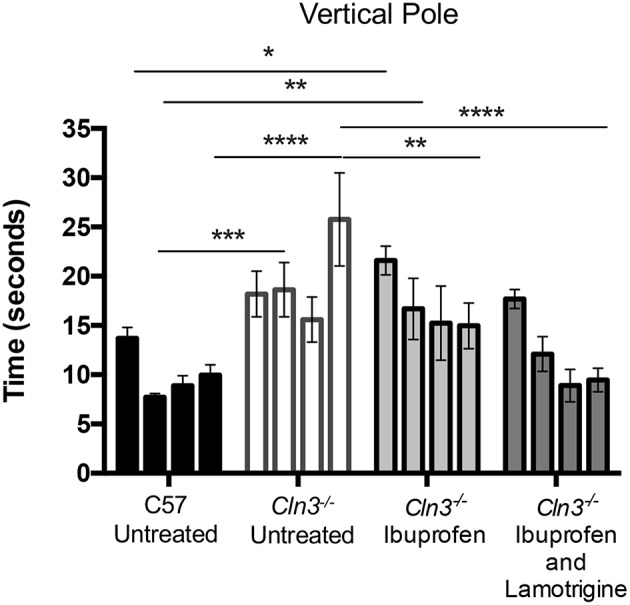
A 3-month treatment with combination of Ibuprofen and Lamotrigine induces significant improvement of motor skills in 6–9-month old Cln3−/− mice. A vertical pole was used to measure the motor skills of 6–9-month-old WT (n = 12) mice and Cln3−/− mice given diet with Ibuprofen, Ibuprofen and Lamotrigine, or powdered diet with no drugs (Untreated) (n = 6–7). Data points represent mean ± S.E.M. of the time (s) mice took to climb down a vertical pole at 6–9 months of age (0–3 months of treatment). Repeated measures two-way ANOVA was applied to compare Control and drug treated mice (*p < 0.05, **p < 0.01, ***p < 0.001, and ****p < 0.0001).